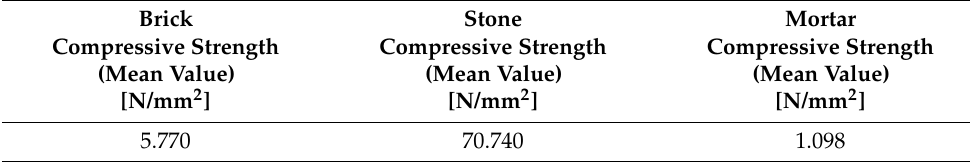
Table 3. Compressive strengths of the masonry